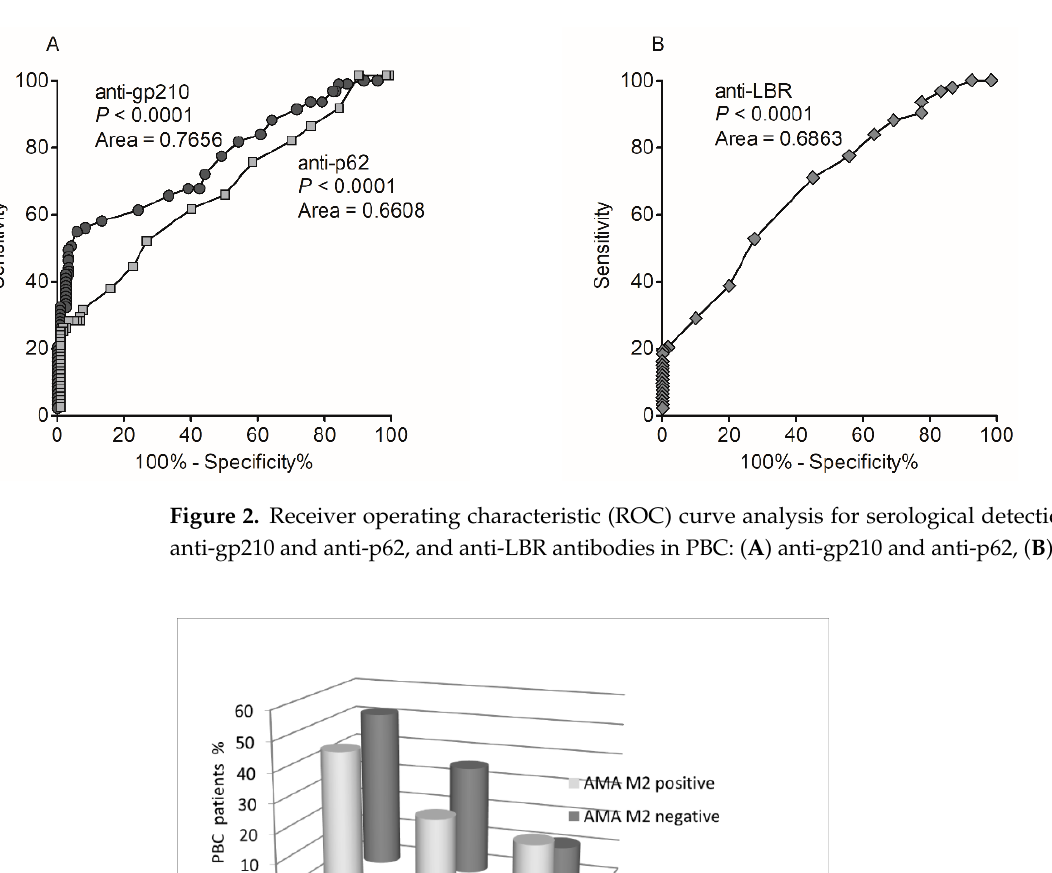
Figure 3. Prevalence of antinuclear antibodies in the studied AMA M2-positive and AMA M2-neg- ative populations.